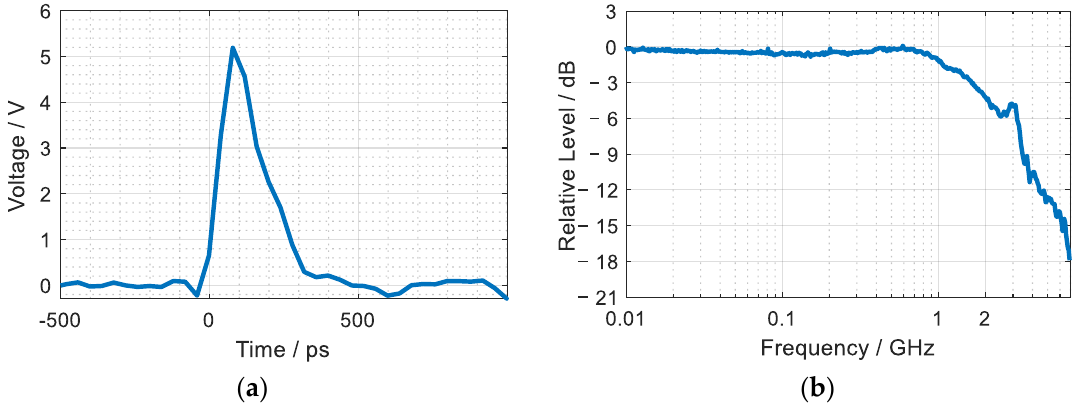
Figure 2. Artificial PD pulse in the ( a ) time-domain; ( b ) frequency-domain (FFT).